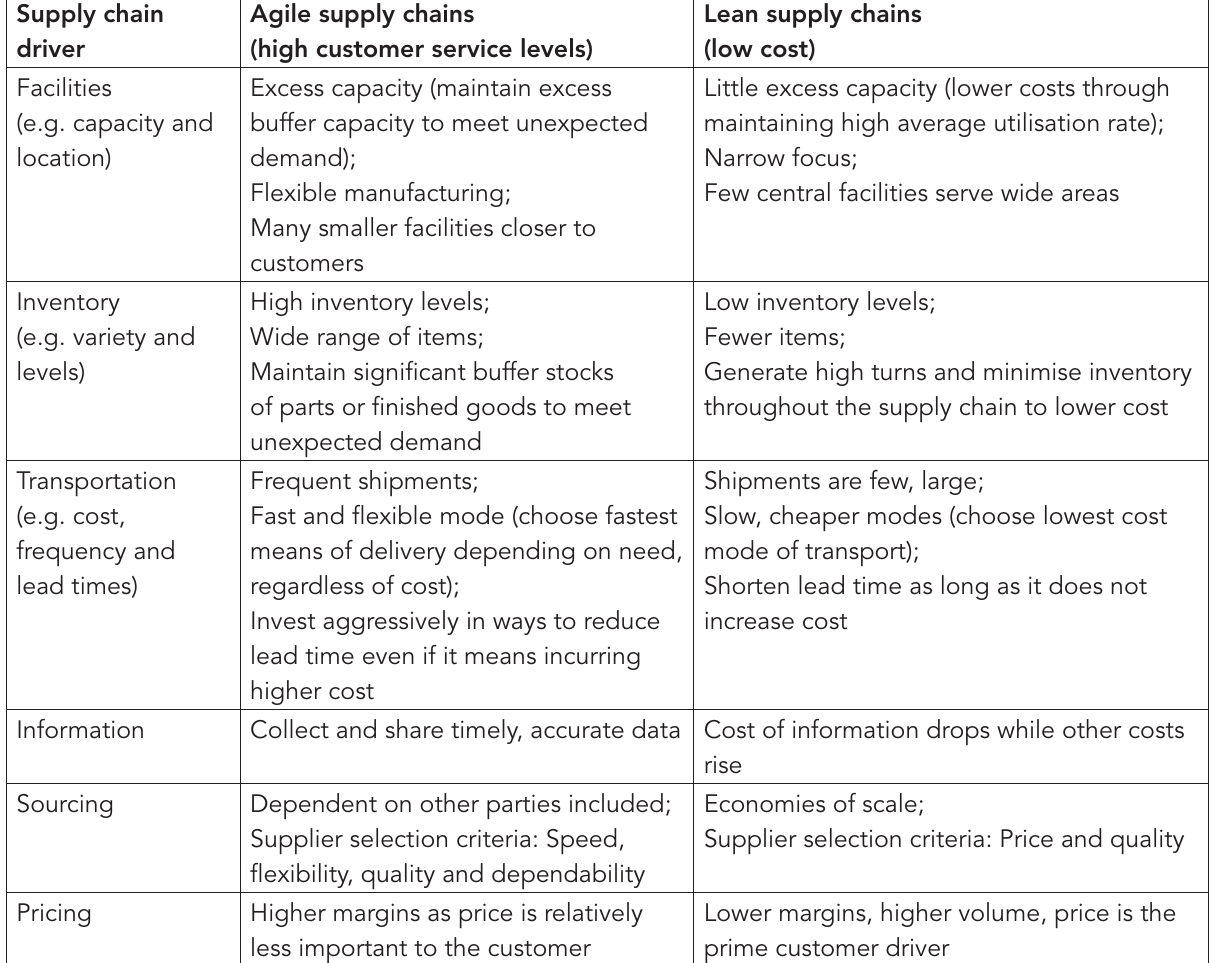
Table 2: The management of supply chain drivers according to lean and agile supply